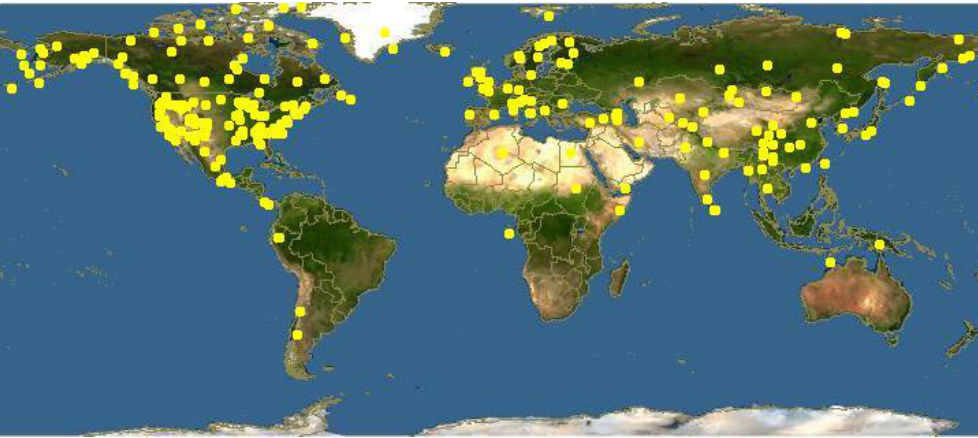
Figure 2. Worldwide distribution of Pedicularis species [source Google images].